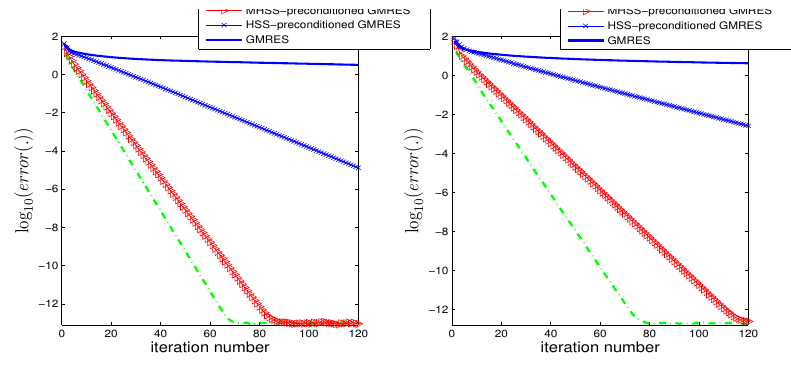
Figure 4. The log 10 of the residual error versus iteration number for Example 1, with n = 20 × 20 (left) and n = 40 × 40 (right).